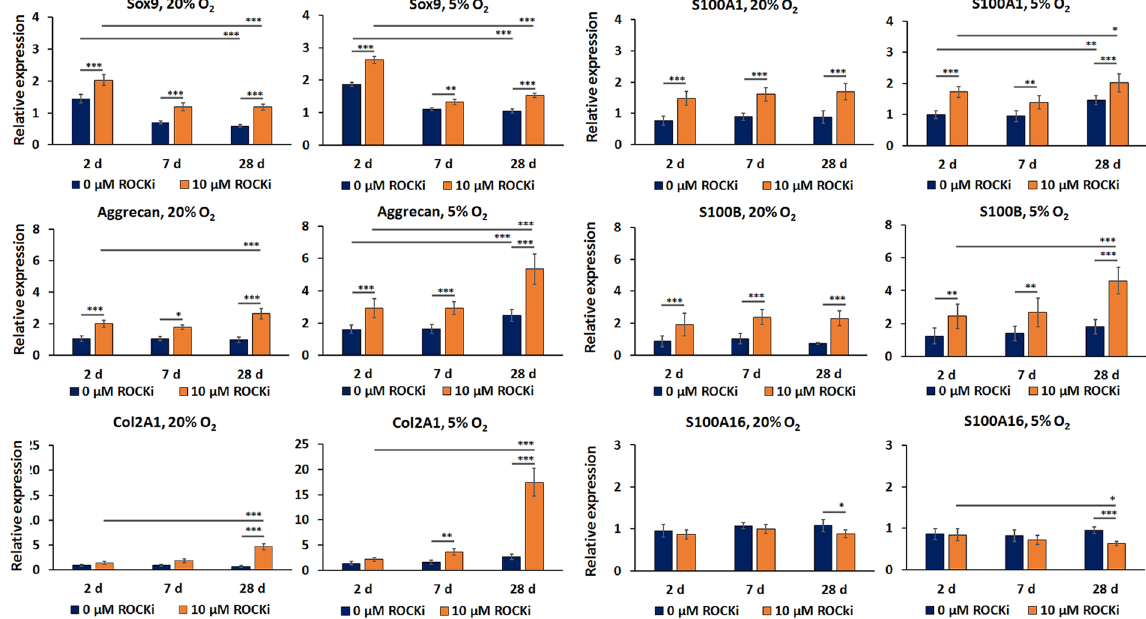
Figure 5. Relative gene expression of SOX9, aggrecan, type II collagen, S100A1, S100A16, S100B at 2, 7 and 28 days of exposure to Y-27632 at normoxia and at hypoxia. The columns describe the mean ± 95% confidence intervals, n = 3 with two replicates. ( * p ≤ 0.05, ** p < 0.01, *** p <